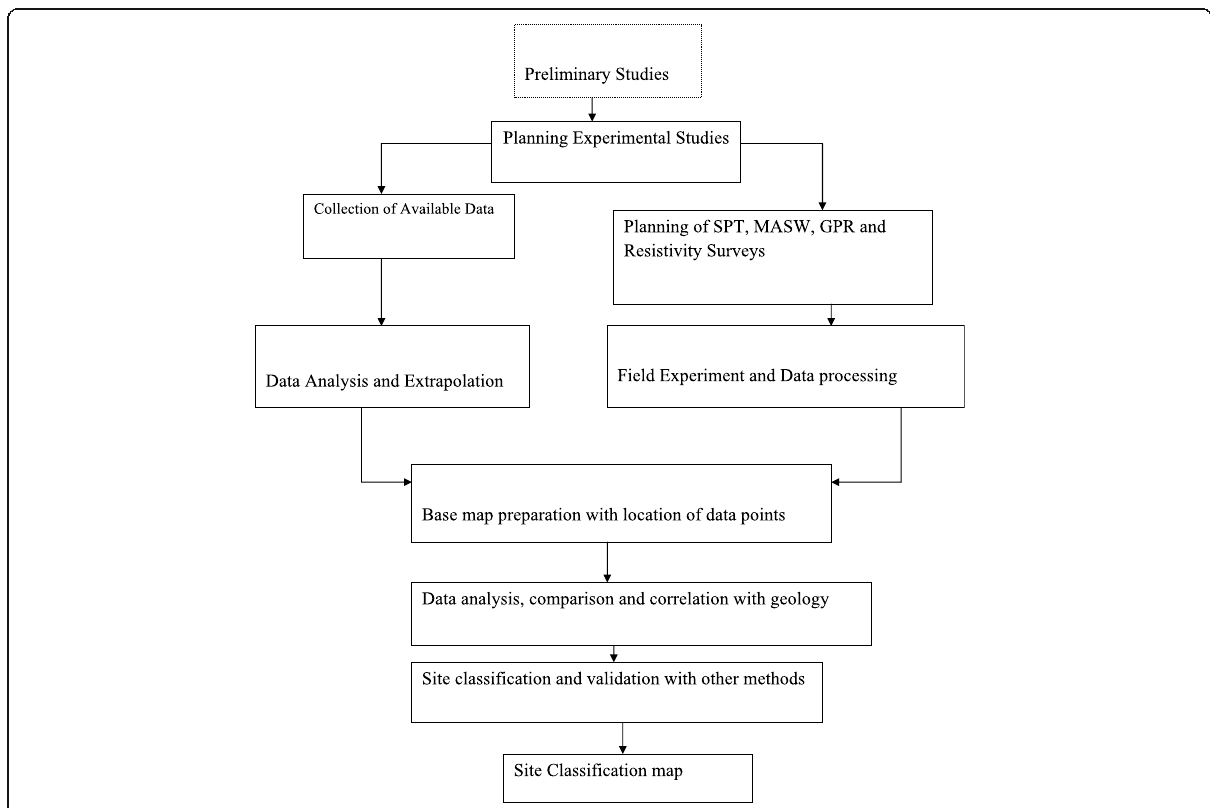
Fig. 1 Steps to be followed for site characterization in seismic assessment and microzonation (Anbazhagan